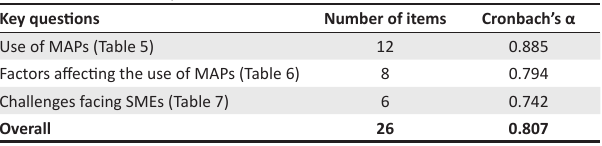
TABLE 2: Cronbach’s alpha for Tables 5 to 7.